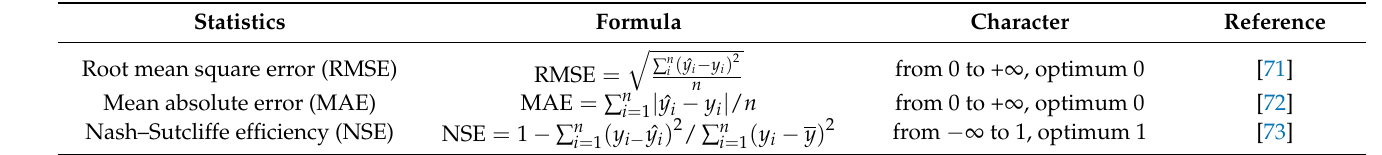
Table 5. Statistics computed to compare the results of the different VIs used for the N parameter